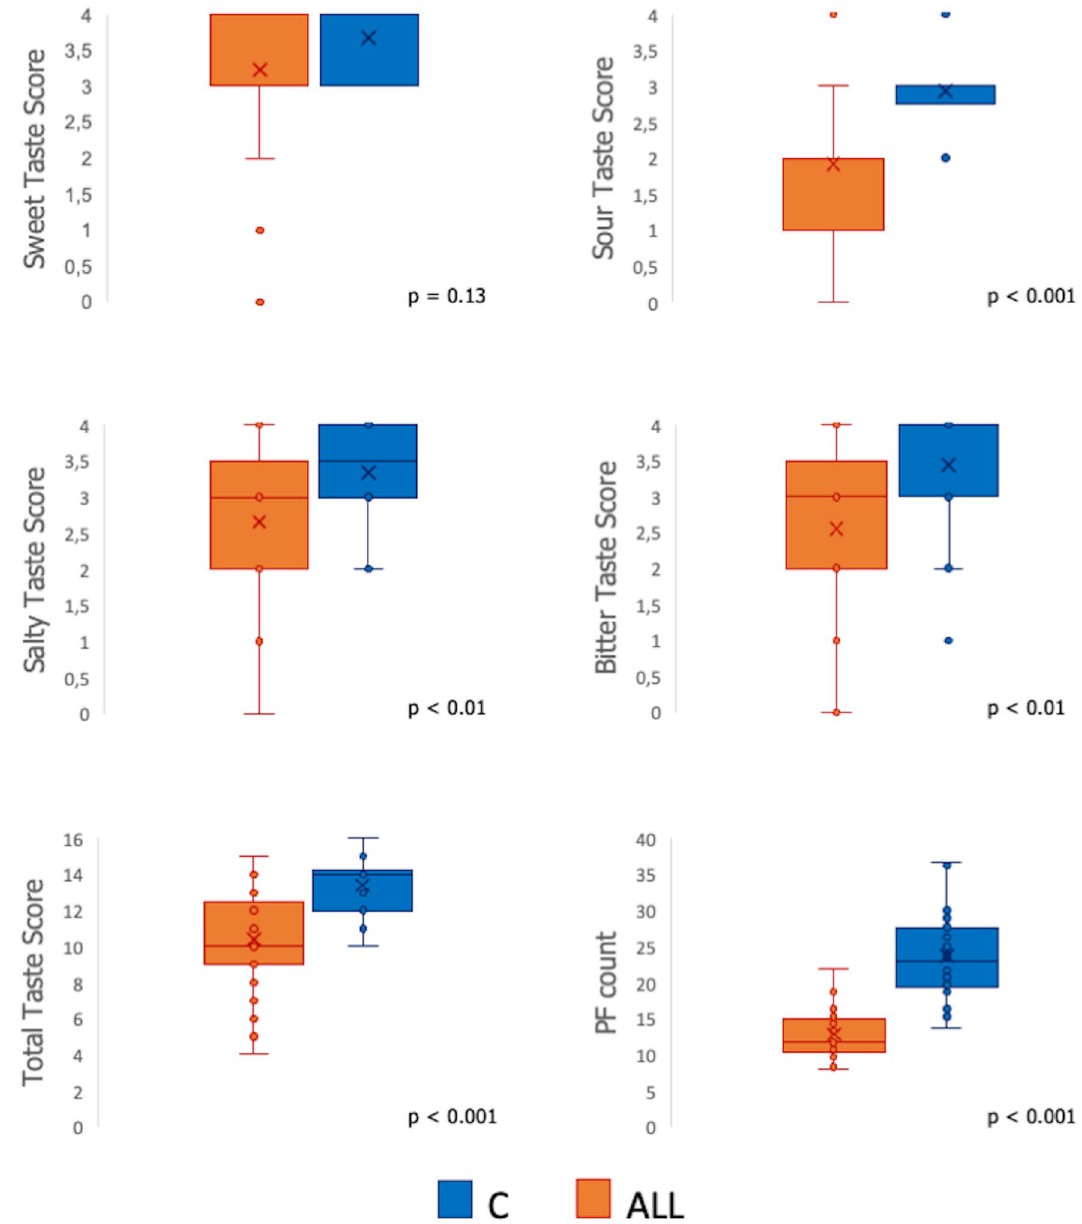
Figure 1. Boxplots showing the differences on both global (TTS) and single scores (Sweet Taste Score, Sour Taste Score, Salty Taste Score and Bitter Taste Score) as a function of allergic condition (ALL: Allergic group; C: Control group). The plots provide a representation of data distribution, individual raw observations, the median (horizontal line) ± IQR (box) within each group. Only statistically significant pairwise differences observed after post hoc Dunn’s test with Bonferroni correction are presented (**p < 0.01; ***p <